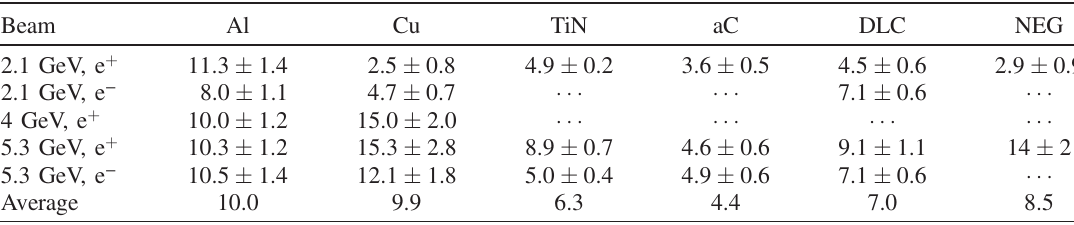
TABLE VIII. Table of best fit quantum efficiencies (in percent).